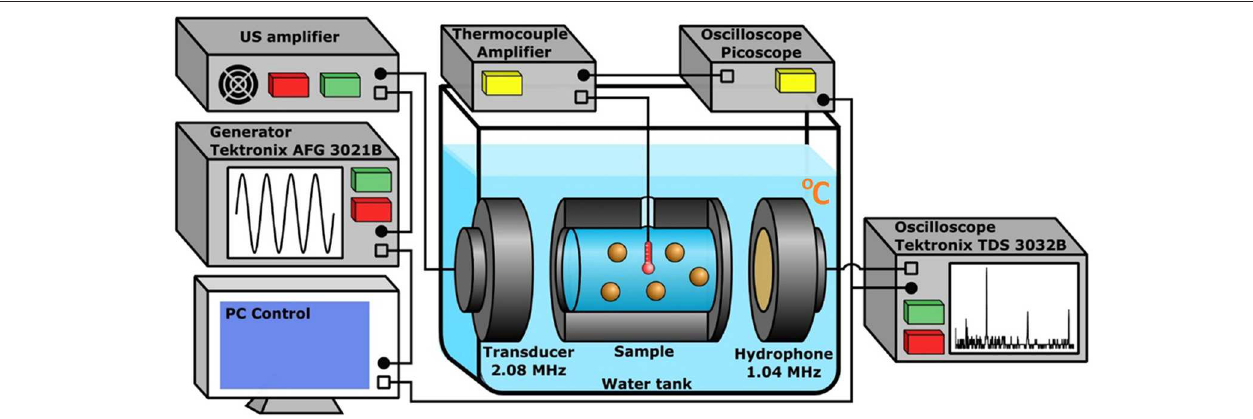
FIGURE 2 | The experimental setup used for the heating measurement and cavitation detection in aqueous suspensions of PSi NPs. The cuvette, US transducer, and hydrophone are immersed into the water tank. The amplified sinusoidal signal from the generator is irradiated by the transducer, the oscilloscope collects data from the hydrophone and performs FFT. The E-type thermocouple measures the heating. The PC reads data from the oscilloscopes and controls the generator.